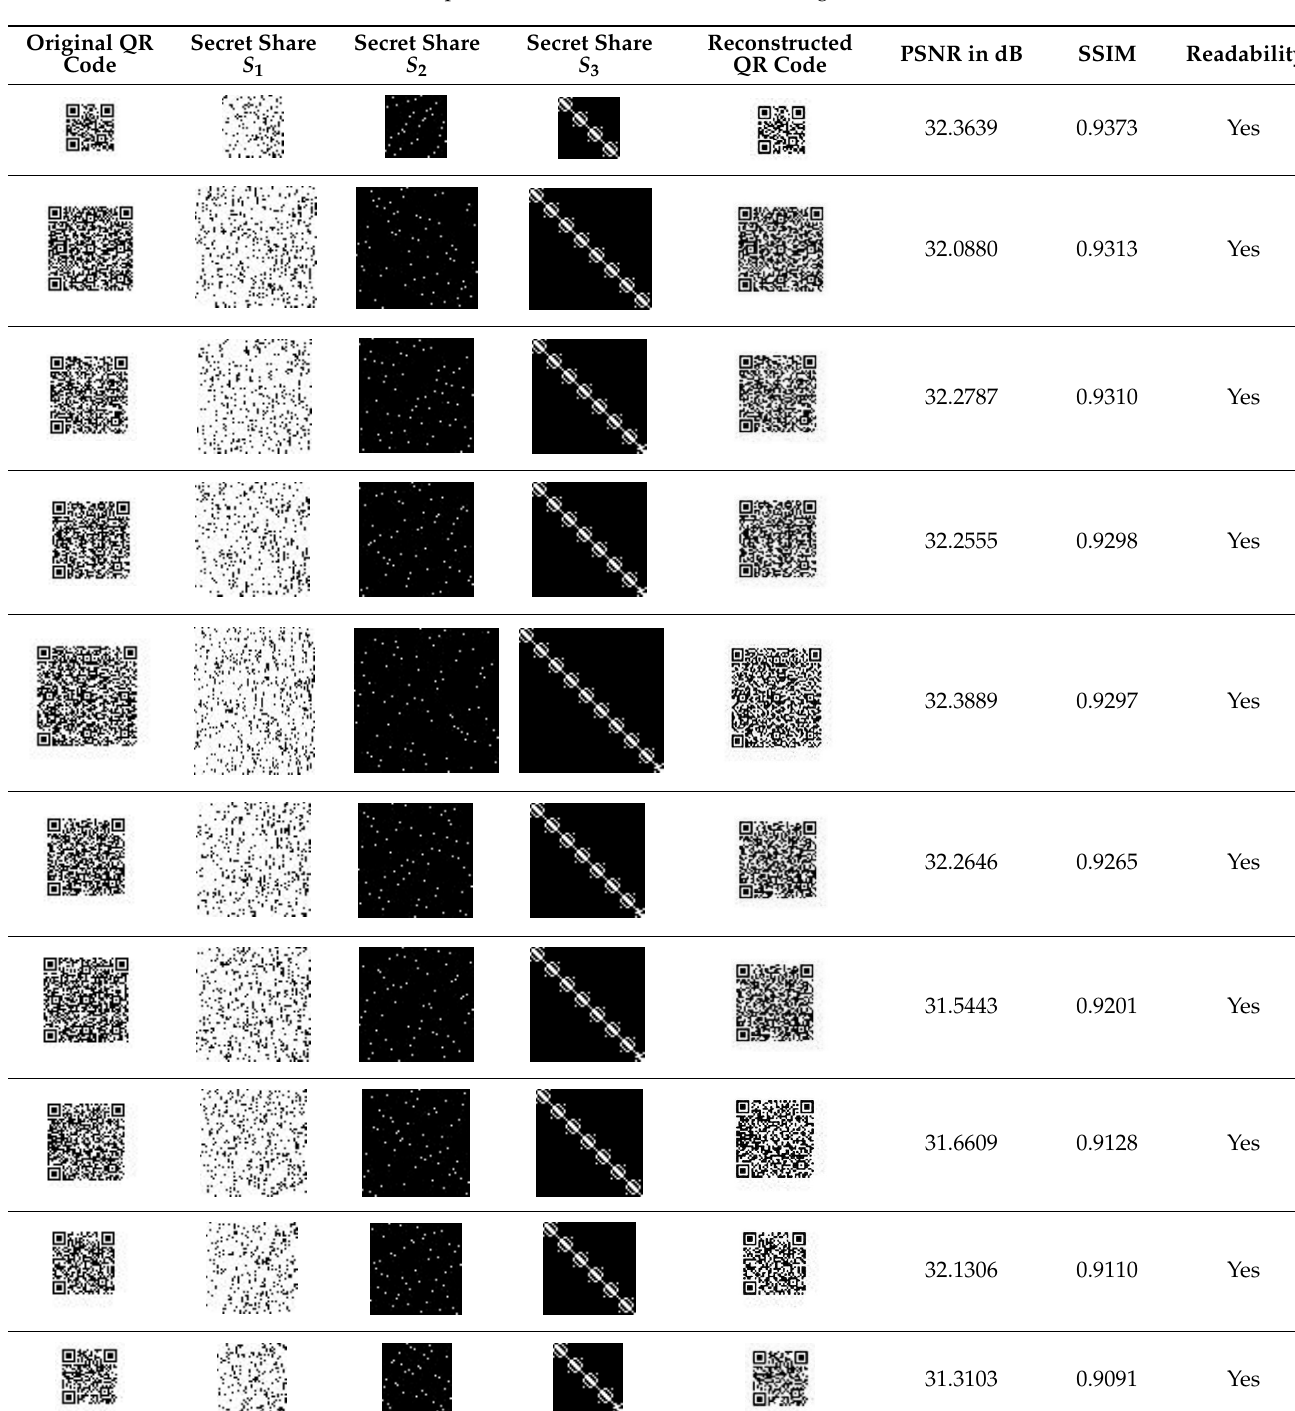
Table 2. Experimental results for QR code sharing and reconstruction.